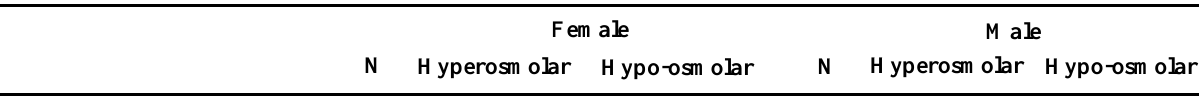
Table 3 – Values of urodynamic variables when vesical filling is accomplished with hyper- and hypo-osmolar solutions in female and male patients (mean ± standard